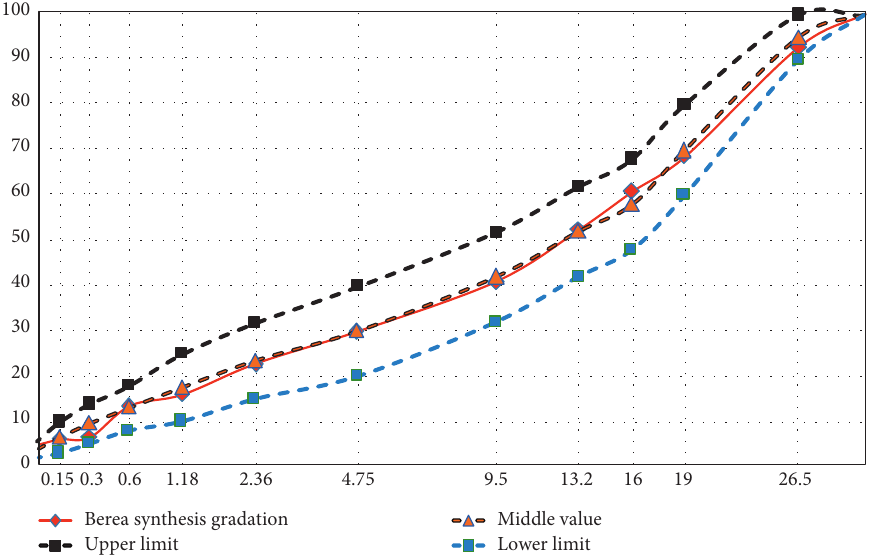
Figure 2: Design grading curve of processed